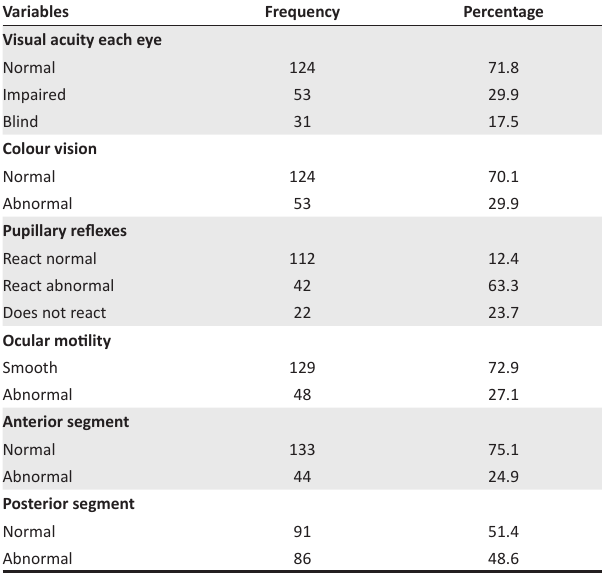
TABLE 4 : Clinical characteristics of human immunodeficiency virus and acquired immunodeficiency syndrome